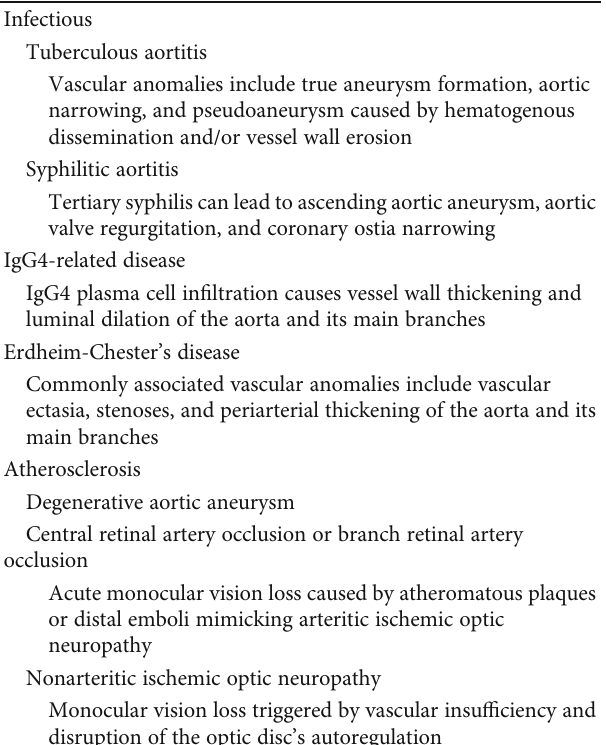
Table 1: Conditions that mimic